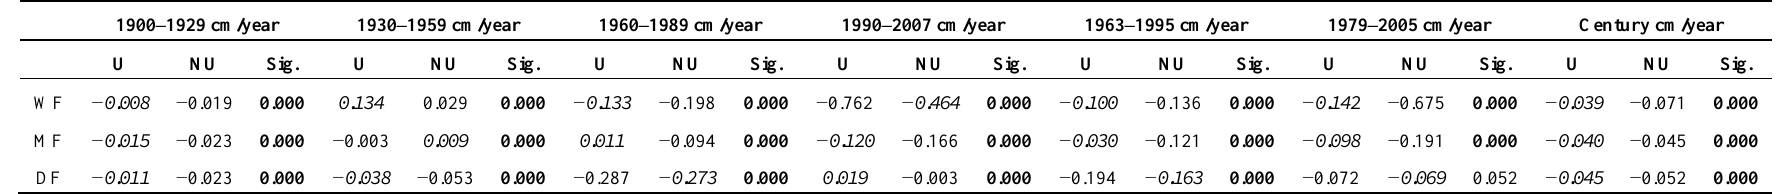
Table 11. The 100 m Grid Cell Yearly Average Total Precipitation Trends for each period and its corresponding Urban vs. Non urban T test significance